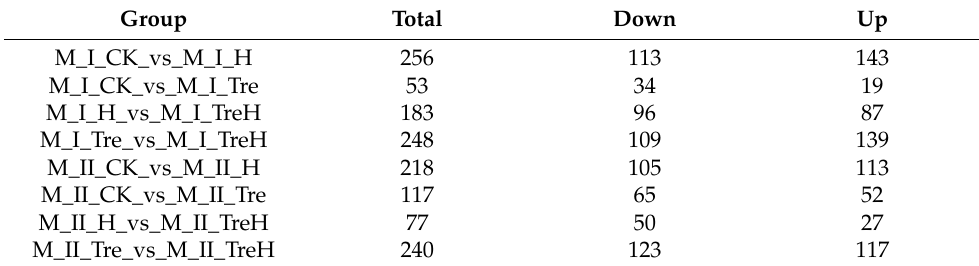
Table 2. Differential metabolite statistics.